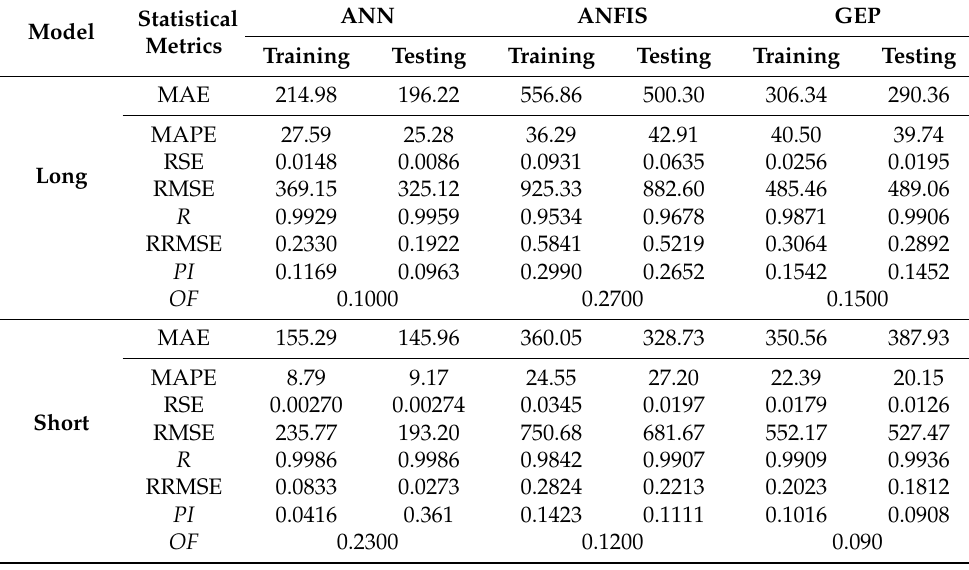
Table 3. Statistical indicators for ANN, ANFIS and GEP models developed for bearing capacity of short and long circular CFST